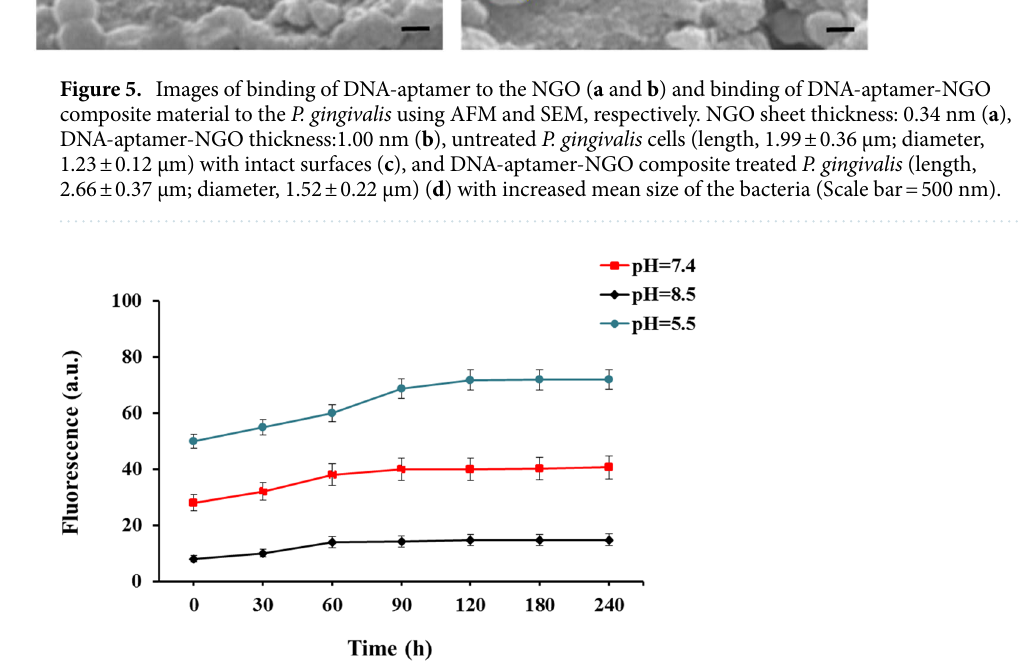
Figure 6. The effect of pH on aptamer binding. pH 8.5 has a positive effect on aptamer binding to the P. gingivalis , and pH 5.5 has an adverse effect on aptamer binding to the P. gingivalis . The fluorescence intensity of the "aptamer-target complex" at pH 8.5 increases slightly in comparison with pH 7.4 while at pH 5.5 low fluorescence intensity has been